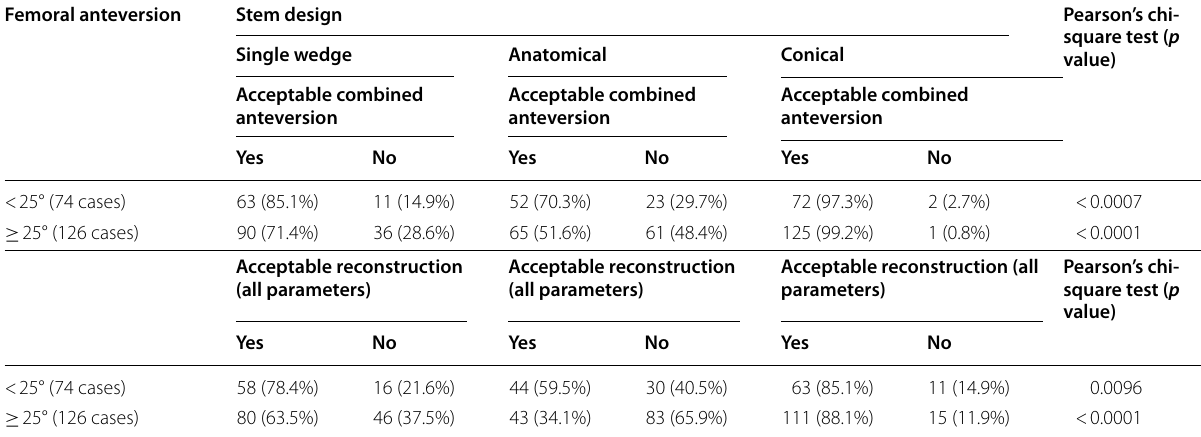
Table 4 The acceptable combined anteversions and acceptable reconstructions (all six criteria were matched) for every stem design stratified according to two classes of femoral anteversion; note that the differences between the groups were significant Femoral